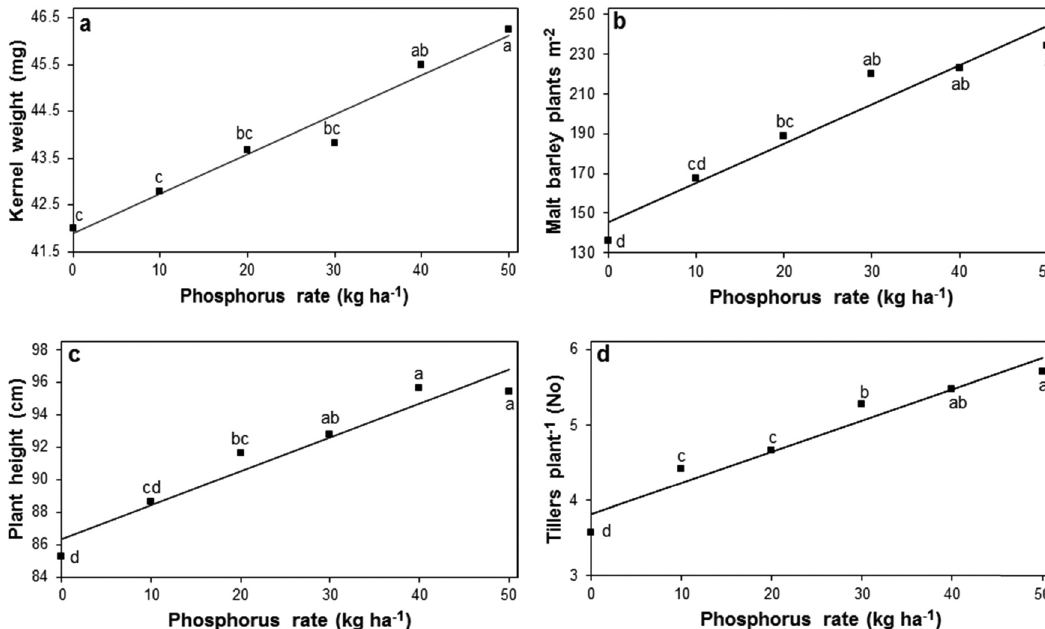
Figure 2: E ff ect of phosphorous fertilizer rate on kernel weight ( a ) , population ( b ) , plant height ( c ) and number of tillers ( d ) of malting